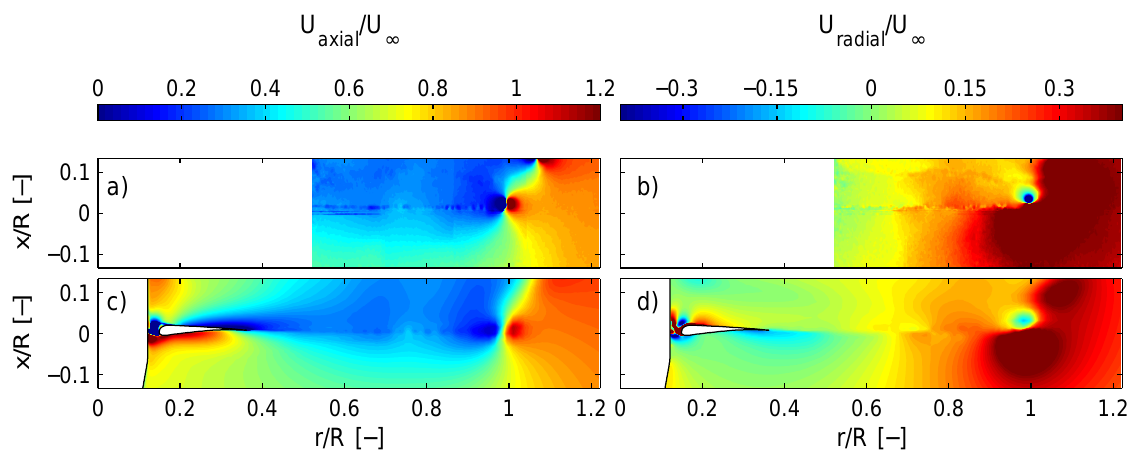
Figure 7. Measured and computed flow field at U 1 = 10 m/s. ( a ) axial wind speed from experiments; ( b ) radial wind speed from experiments; ( c ) axial wind speed from simulations; ( d ) radial wind speed from